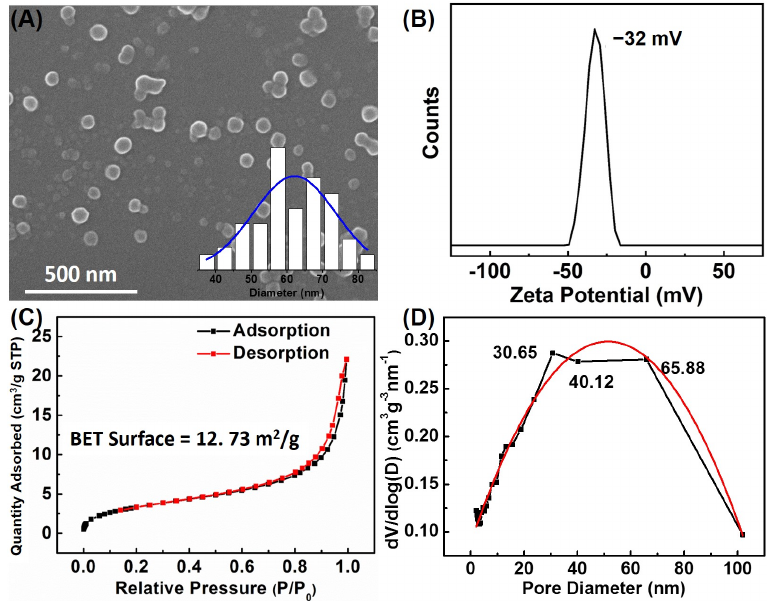
Figure 3. ( A ) SEM image of HCCP-V dispersed in EtOH, inset is a size distribution based on the SEM image. ( B ) Zeta potential result for the dispersion of HCCP-V in H 2 O. ( C ) N 2 isotherm adsorption and desorption curve ( C ) and pore size distribution ( D ) of HCCP-V.